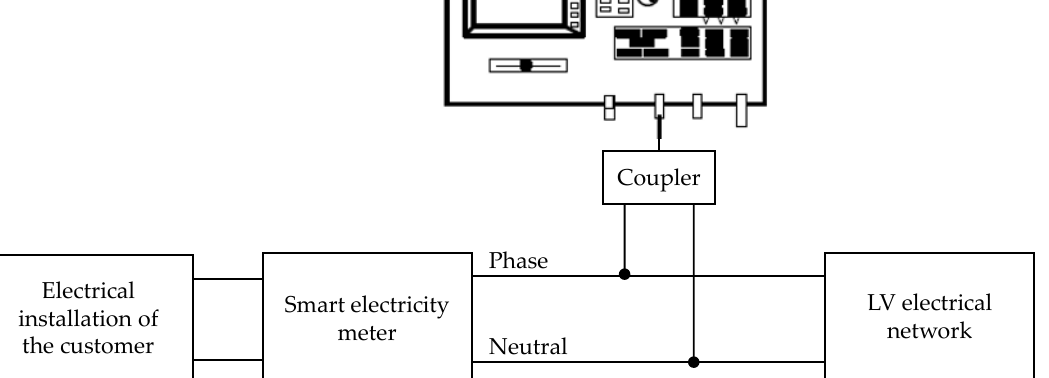
Figure 4. Spectral setup measurement protocol.